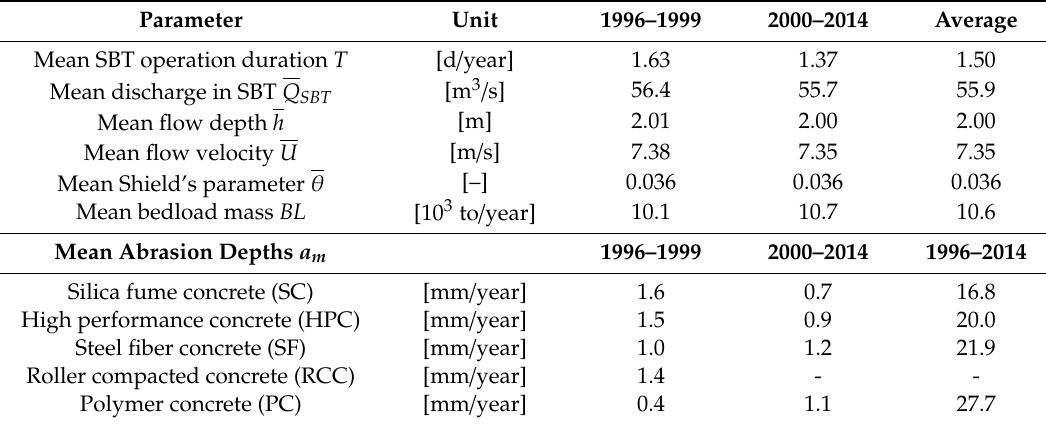
Table 5. Mean SBT operation conditions, bedload transport masses and abrasion depths in the Runcahez SBT for 1996–1999 and 2000–2014 and the overall